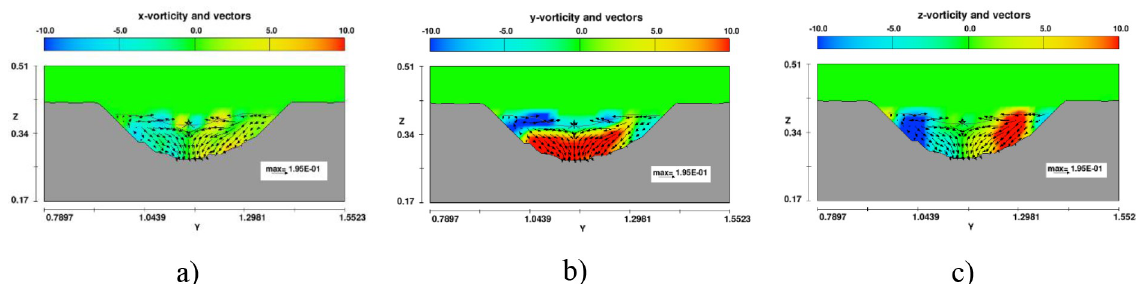
Fig 15. Depth-averaged velocity distributions in section 5.